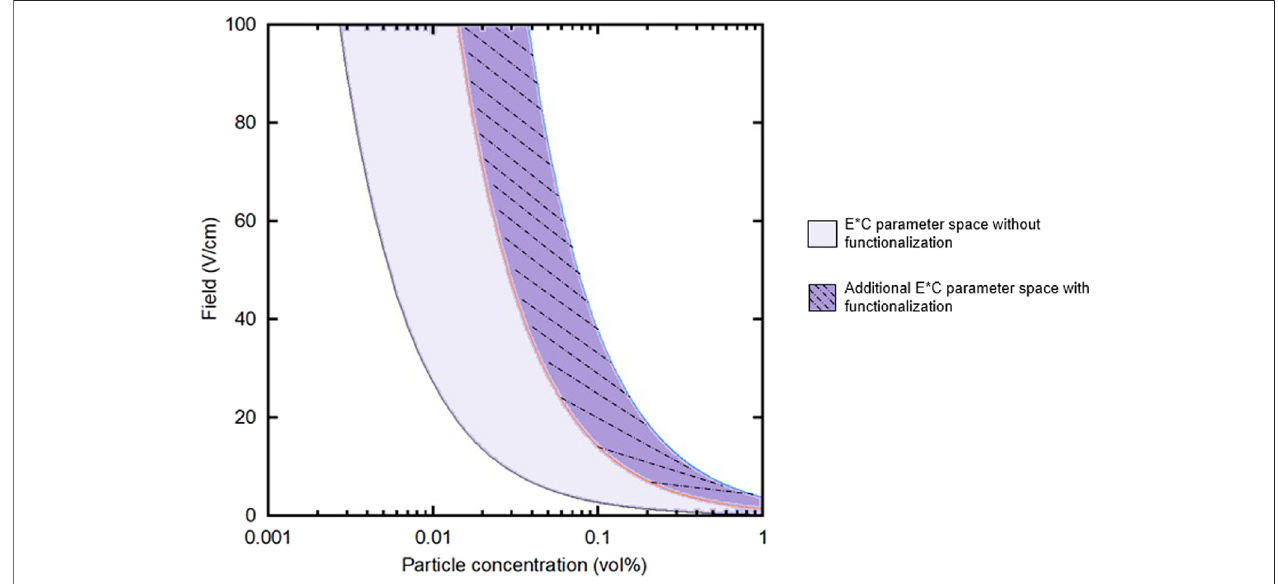
FIGURE 9 | Field ( E ) vs. particle concentration ( C ) plot showing the E*C processing area, shaded in solid, for the parameter space used in this work. The solid- dashed line area represents the additional parameter space that is available by functionalizing substrates with chelating agents.